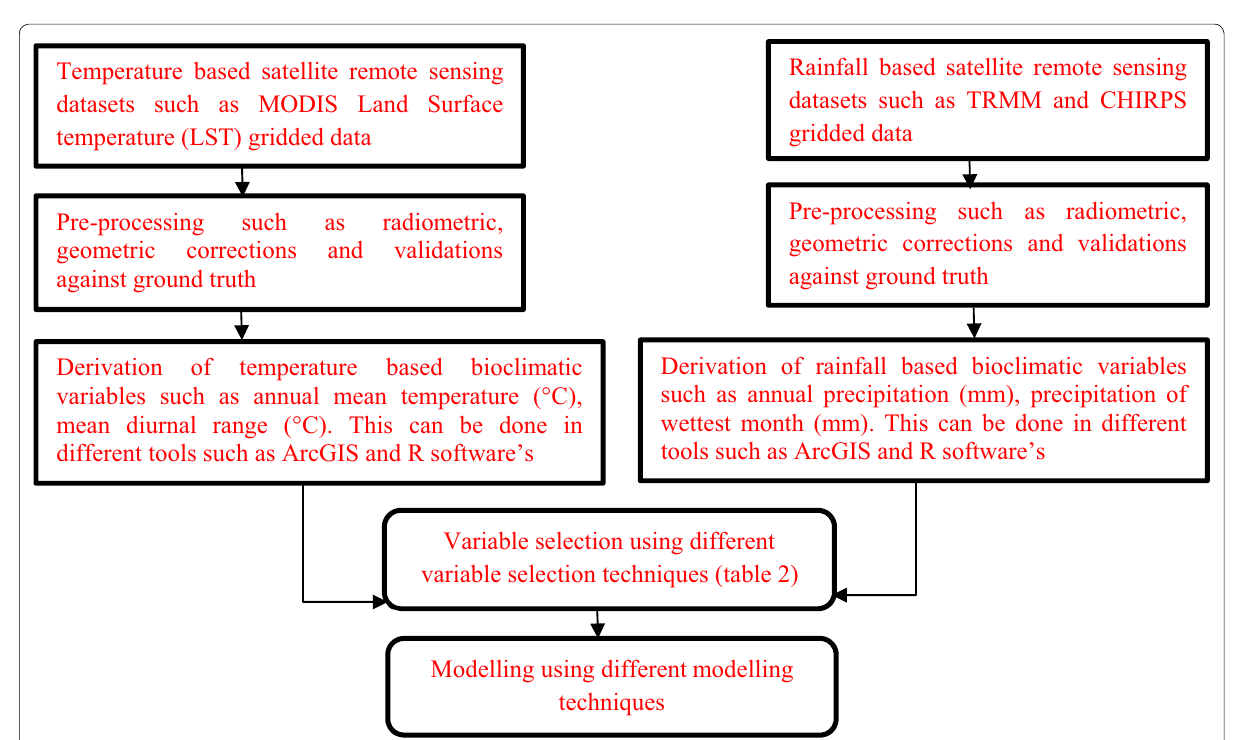
Fig. 3 Derivation of bioclimatic variables from remotely sensed data (adapted from Amiri et al. 2020; Deblauwe et al.